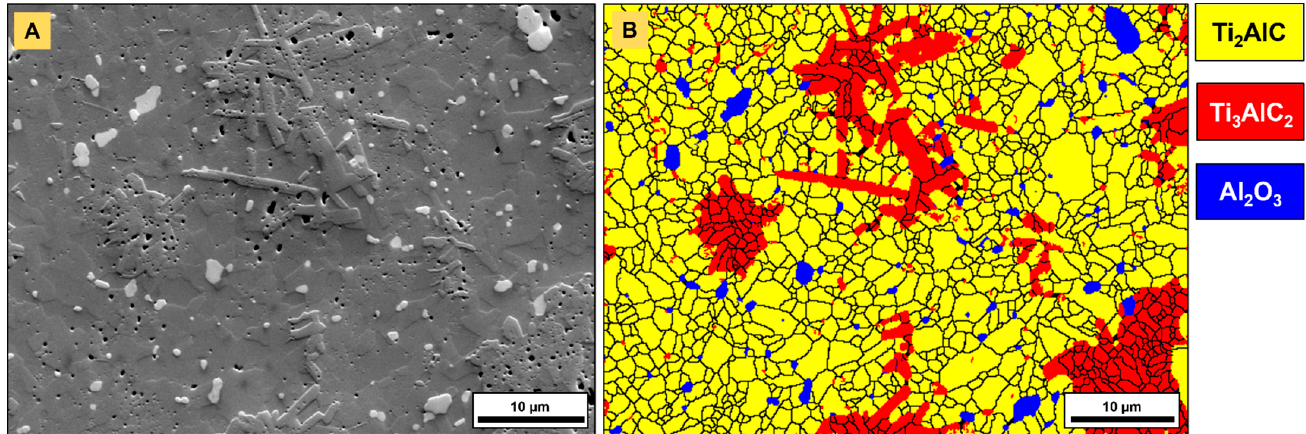
Figure 6. EBSD analysis of an injection molded monolithic Ti 2 AlC nut specimen after sintering procedure 1 (PS1250 + PBS1200): ( A ) SE image shows height offset and porosity in Ti 3 AlC 2 grains and ( B ) corresponding EBSD phase map with areal fractions of 77.5% Ti 2 AlC, 18.8% Ti 3 AlC 2 and 3.2% Al 2 O 3 .